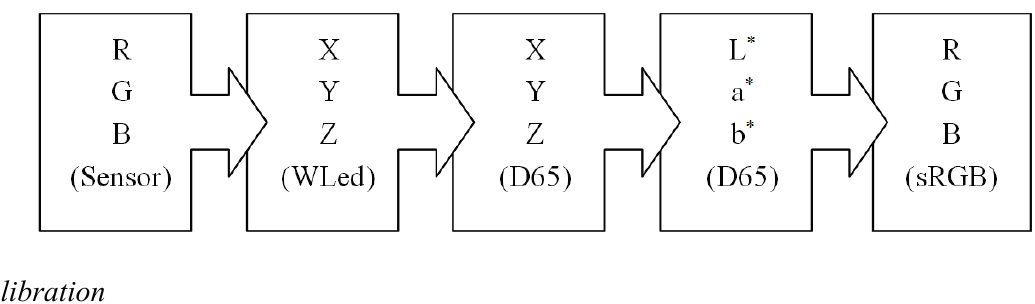
Figure 6. Colorimetric transformations.